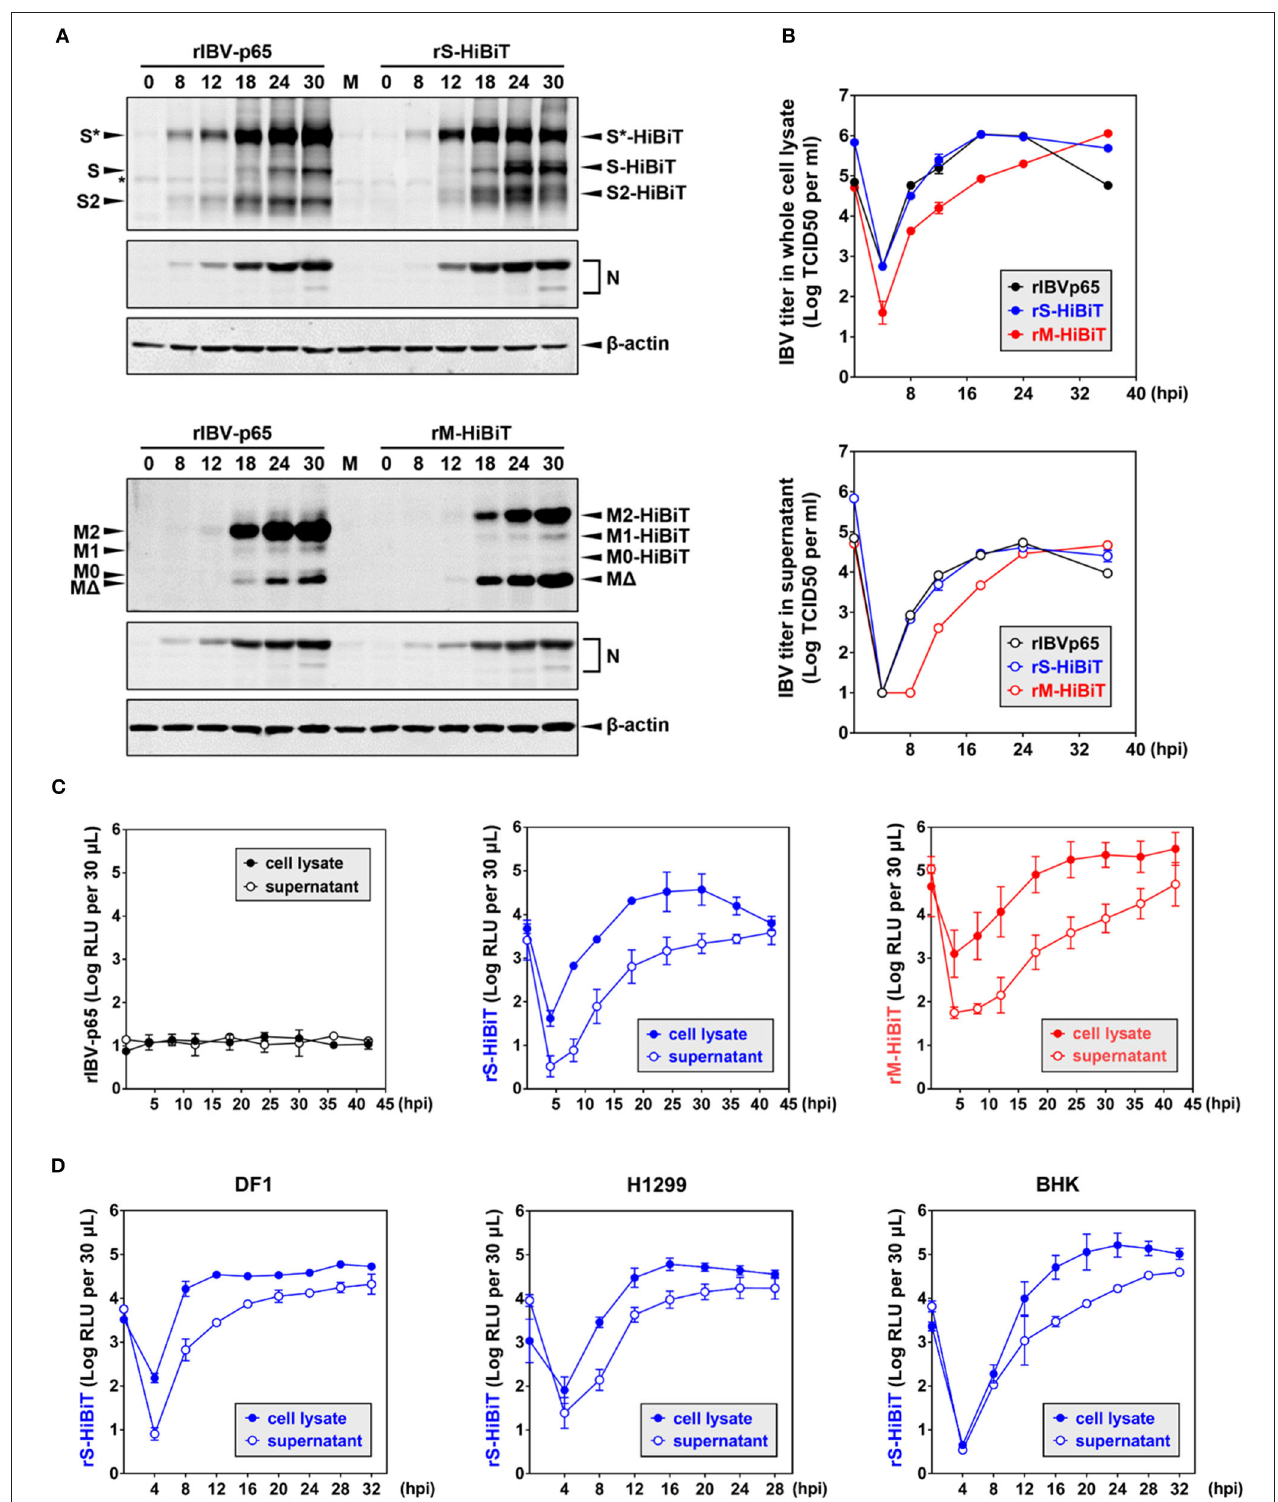
FIGURE 3 | Growth kinetics of HiBiT-tagged rIBVs in culture cells. (A) Viral protein synthesis in Vero cells infected with the rIBVs in a time course infection. Vero cells were infected with rIBV-p65, rS-HiBiT, or rM-HiBiT at MOI ∼ 2. Cell lysates were harvested by three freeze/thaw cycles at the indicated time points and subjected to SDS-PAGE, followed by Western blot analysis using antisera against IBV S2, M, and N. Beta-actin was used as the loading control. The experiment was repeated three times with similar results, and the result of one representative experiment is shown. (B) Growth kinetics of the three rIBVs in Vero cells. Vero cells were